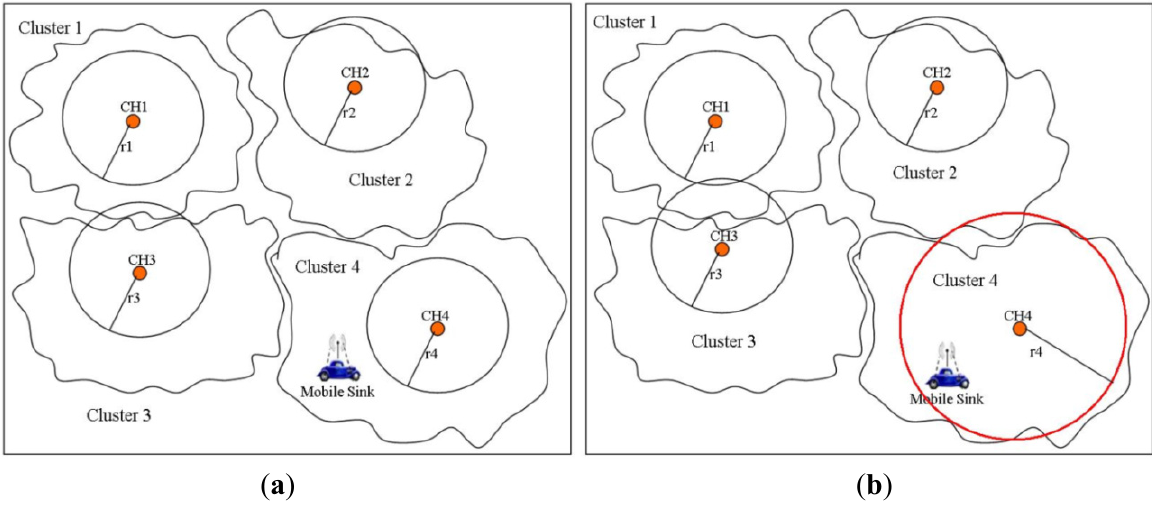
Figure 8. ( a ) Network Topology with default radio settings; ( b ) Network Topology after radio